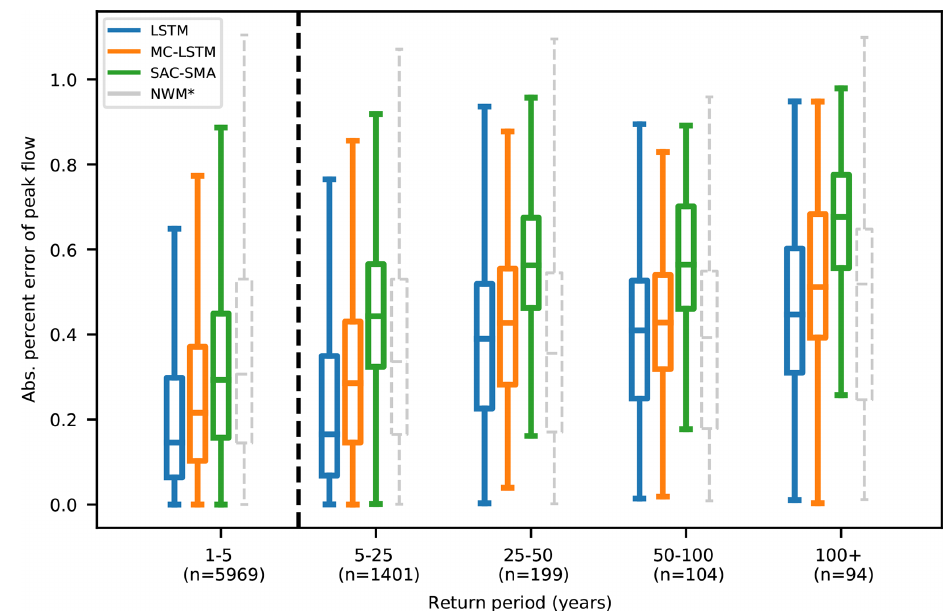
Figure 2. Average absolute percent bias of daily peak flow estimates from four models binned down by return period, showing results from models trained only on water years with return periods less than 5 years. The 1- to 5-year return period bin (left of the black dashed line) shows statistics calculated on training data, whereas bins with return periods of more that 5 years (to the right of the black dashed line) show statistics calculated on testing data. The LSTM, MC-LSTM, and SAC-SMA models were all trained (calibrated) on the same data and time period. The NWM was calibrated on the same forcing data but on a contiguous time period that does not exclude extreme events, as described in Sect.